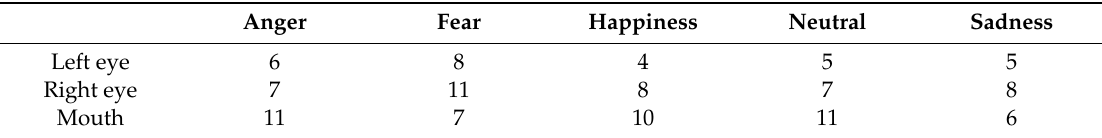
Table 1. Median saliency values for each feature of interest for the di ff erent emotional expressions. Anger Fear Happiness Neutral Sadness Left eye 6 8 4 5 5 Right eye 7 11 8 7 8 Mouth 11 7 10 11 6 Note. Lower numbers indicate higher